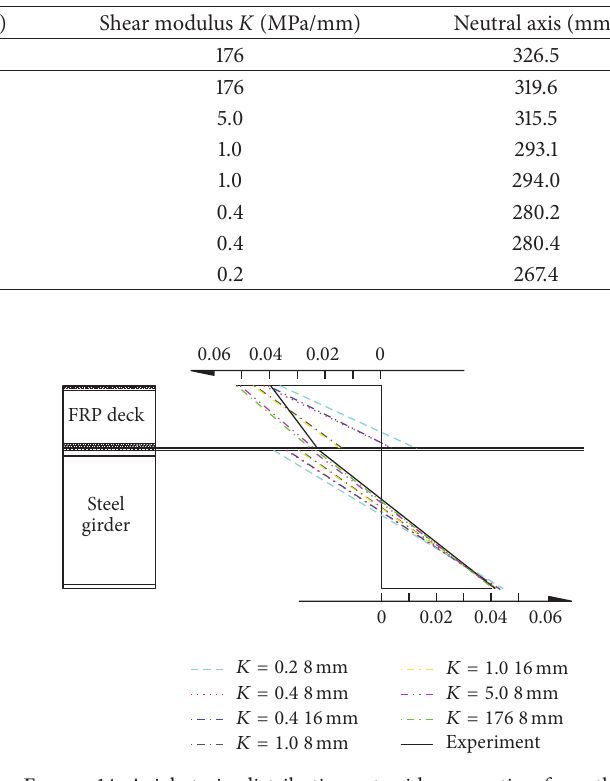
Figure 14: Axial strain distributions at midspan section from the parametric